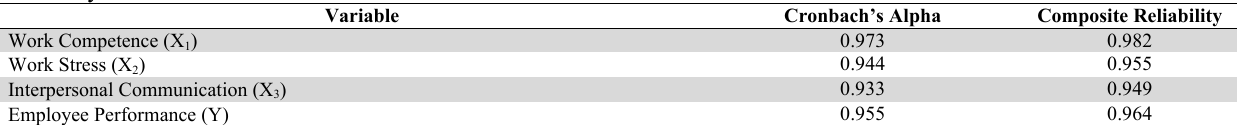
Source: Data analysis results from SmartPLS